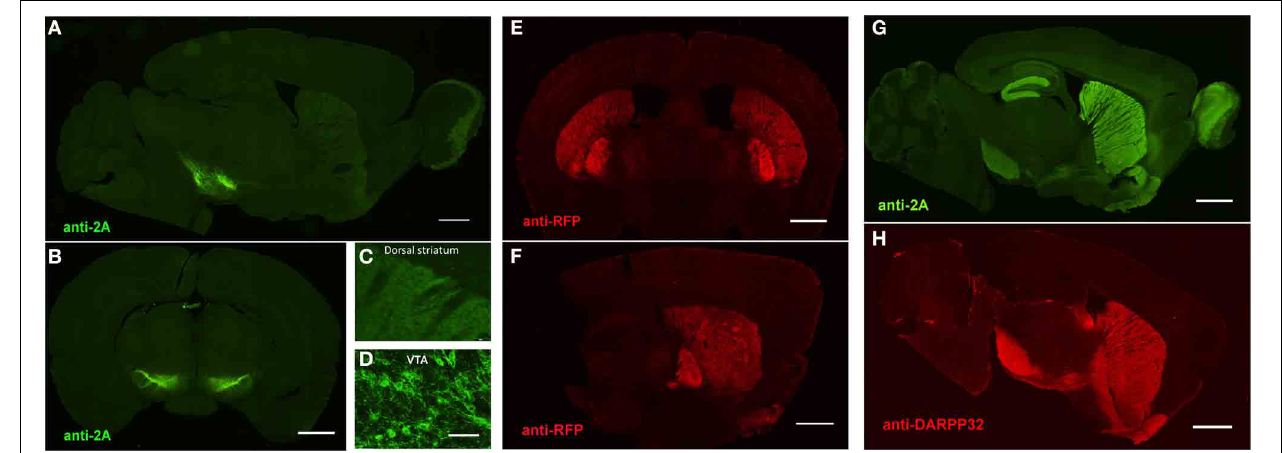
FIGURE 5 | Preserved cell-type specific expression patterns in BAC transgenic mice created with advanced recombineering strategies. (A–D) Anti-2A slice staining in brain slices from DAT-ChETA line 3 mice reveals the distribution of membrane-targeted ChETA protein. Sagittal (A) and coronal (B) sections showing ChR2 expression in midbrain dopamine neurons. (C,D) High magnification images of axon terminal labeling in the dorsal striatum (C) and labeled neurons in the ventral tegmental area (D) . (E,F) Anti-RFP slice staining in brain slices from A2A-ChETA line 13 mice